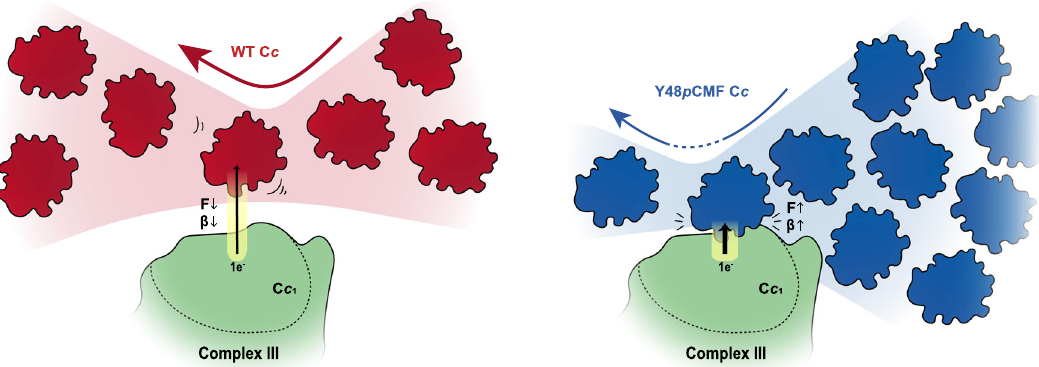
Fig. 5 | Proposed model showing how phosphorylation of cytochrome c pro- motes a closer contact with cytochrome c 1 and diminishes the turnover of moleculesatcomplexIII. ( Left) WTcytochrome c (red)canreceiveelectronsfrom cytochrome c 1 of complex III at long distances (low β ). Overall turnover of cyto- chrome c molecules at complex III is high due to reversible binding in equilibrium conditions(lowF). (Right) ComparedtoWTC c (red),thedissociationconstant( K D ) of the Y48 p CMF variant (blue) is lower and it must get closer to complex III for